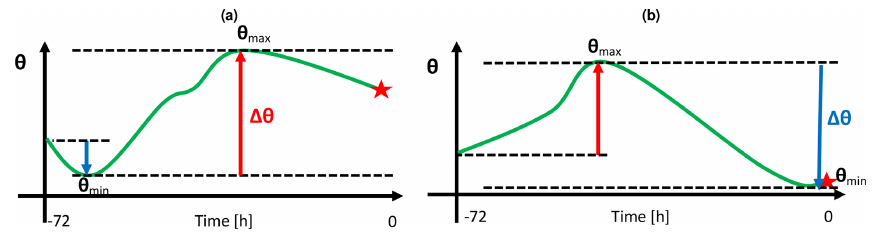
Figure 2. This schematic depicts the potential temperature change (cid:49)θ for a 3d period. The red star indicates the starting point of the backward trajectory. (a) Diabatic heating (red arrow) exceeds diabatic cooling (blue arrow). (b) Diabatic cooling exceeds diabatic